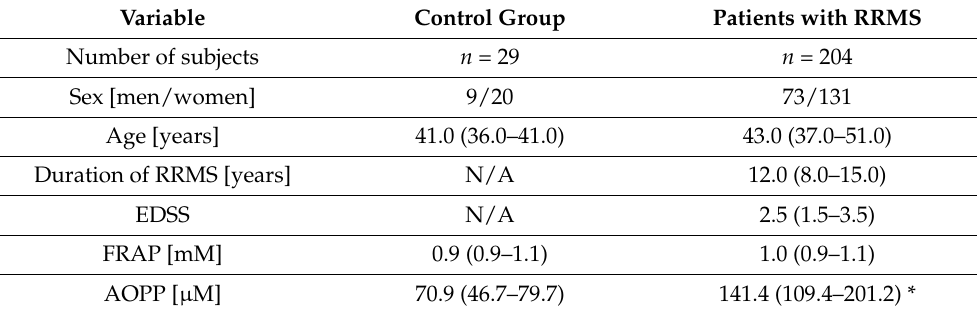
Table 1. Basic characteristics of patients with RRSM and control group.